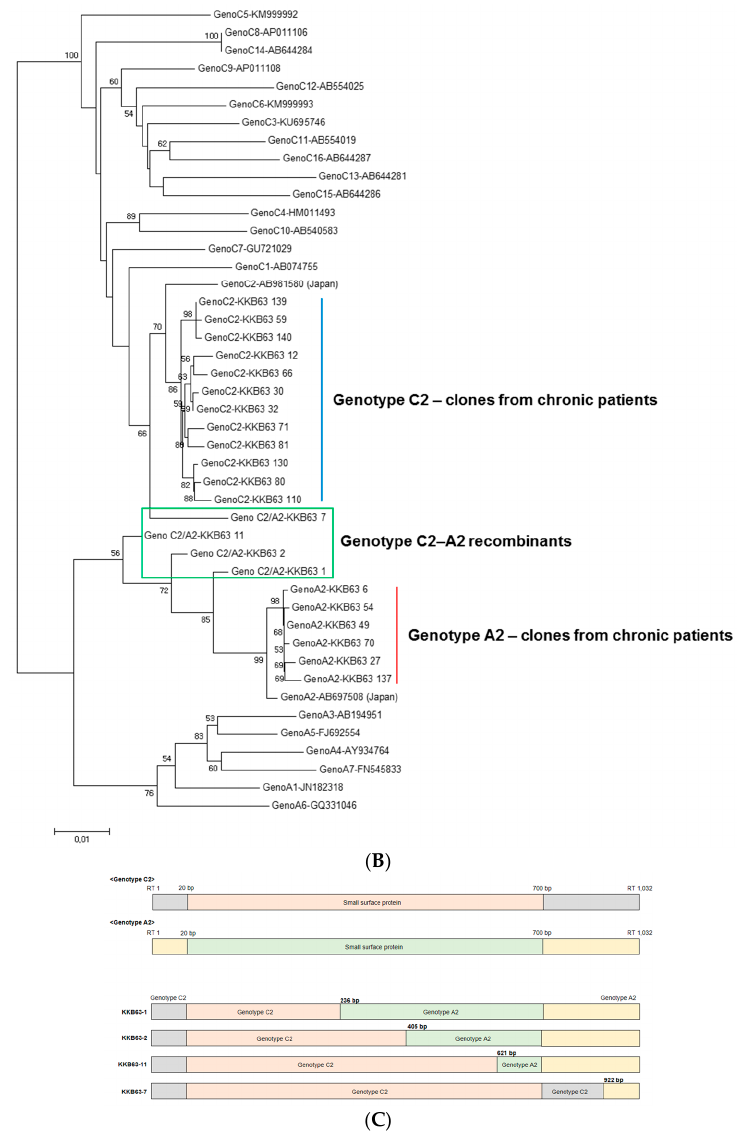
Figure 1. Phylogenetic analysis of 22 clones from a Korean chronically infected patient based on the 1032-bp reverse transcriptase (RT) region and schematic representation of the RT and the overlapping hepatitis B surface antigen (HBsAg) regions showing recombination profiles of the four genotype A2/C2 recombinants. Phylogenetic relationships of 22 clones were compared with ( A ) genotype A–H reference strains and ( B ) sub-genotypes of genotype A and C based on the RT gene (1032 bp). The bootstrap values were calculated from 1000 replications and Bootstrap values of <50% are not shown. ( C ) Analysis of alignments revealed that the RT region overlaps the HBsAg region (21–700 bp). The four recombinants contained different types of recombination breakpoints. The recombination break points of KBB63-1, KBB63-2, KBB63-11 and KBB63-7 are located at the positions nt 236, nt 405, nt 621 and nt 922, respectively.